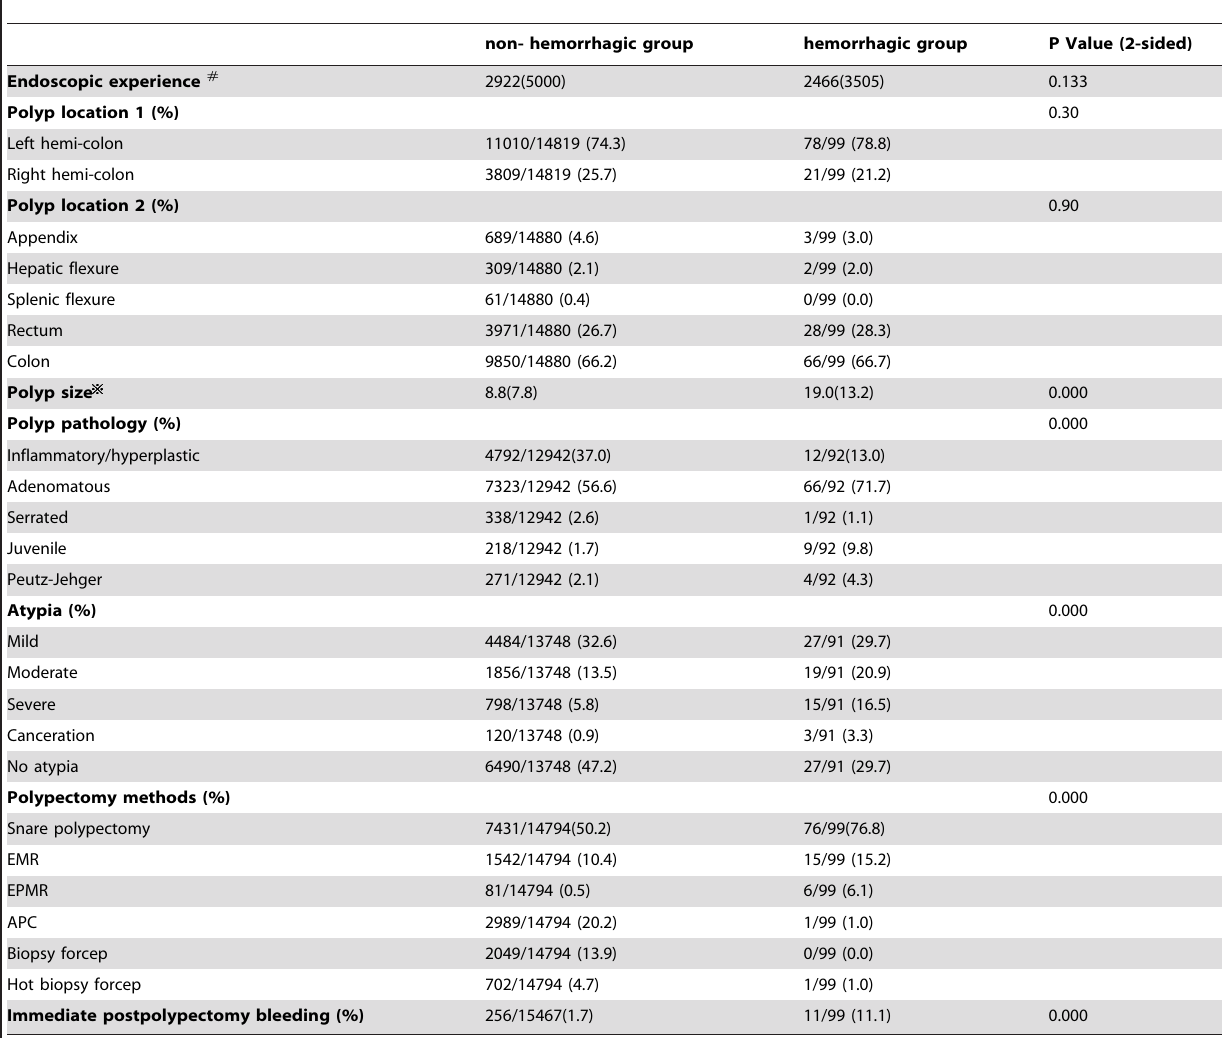
Table 2. Univariate analysis of risk factors for delayed colonic postpolypectomy hemorrhage.